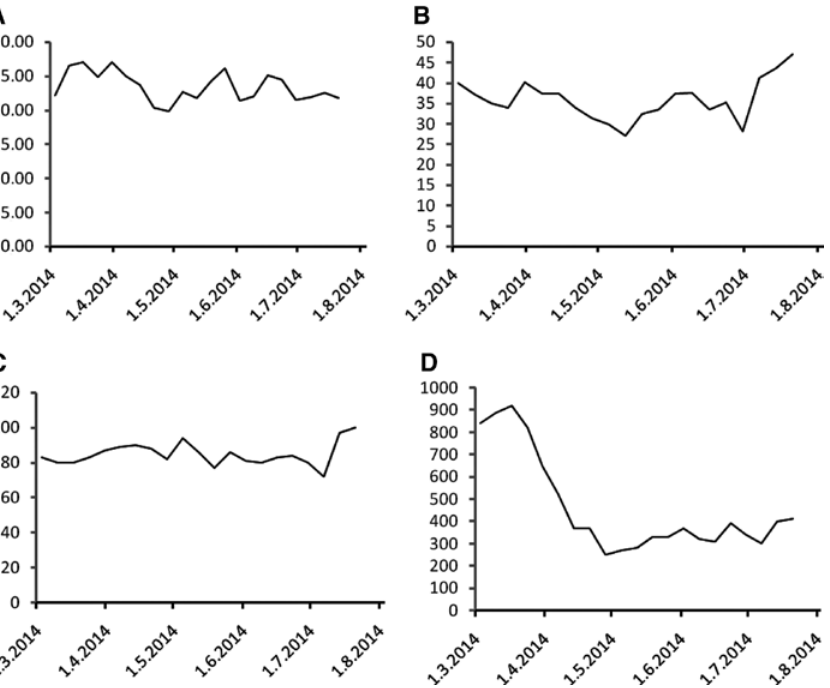
Figure 3: α -Tocopherol, 25-hydroxy vitamin D3, hemoglobin and lymphocyte counts during the course of treatment. (A) Serum α -tocopherol concentrations (in μ mol/L), (B) serum 25-hydroxy vitamin D3 concentrations (in nmol/L), (C) hemoglobin concentra- tions (in g/L) and (D) peripheral blood lymphocyte counts (as cells/ μ L) measured in weekly intervals during the course of treatment.